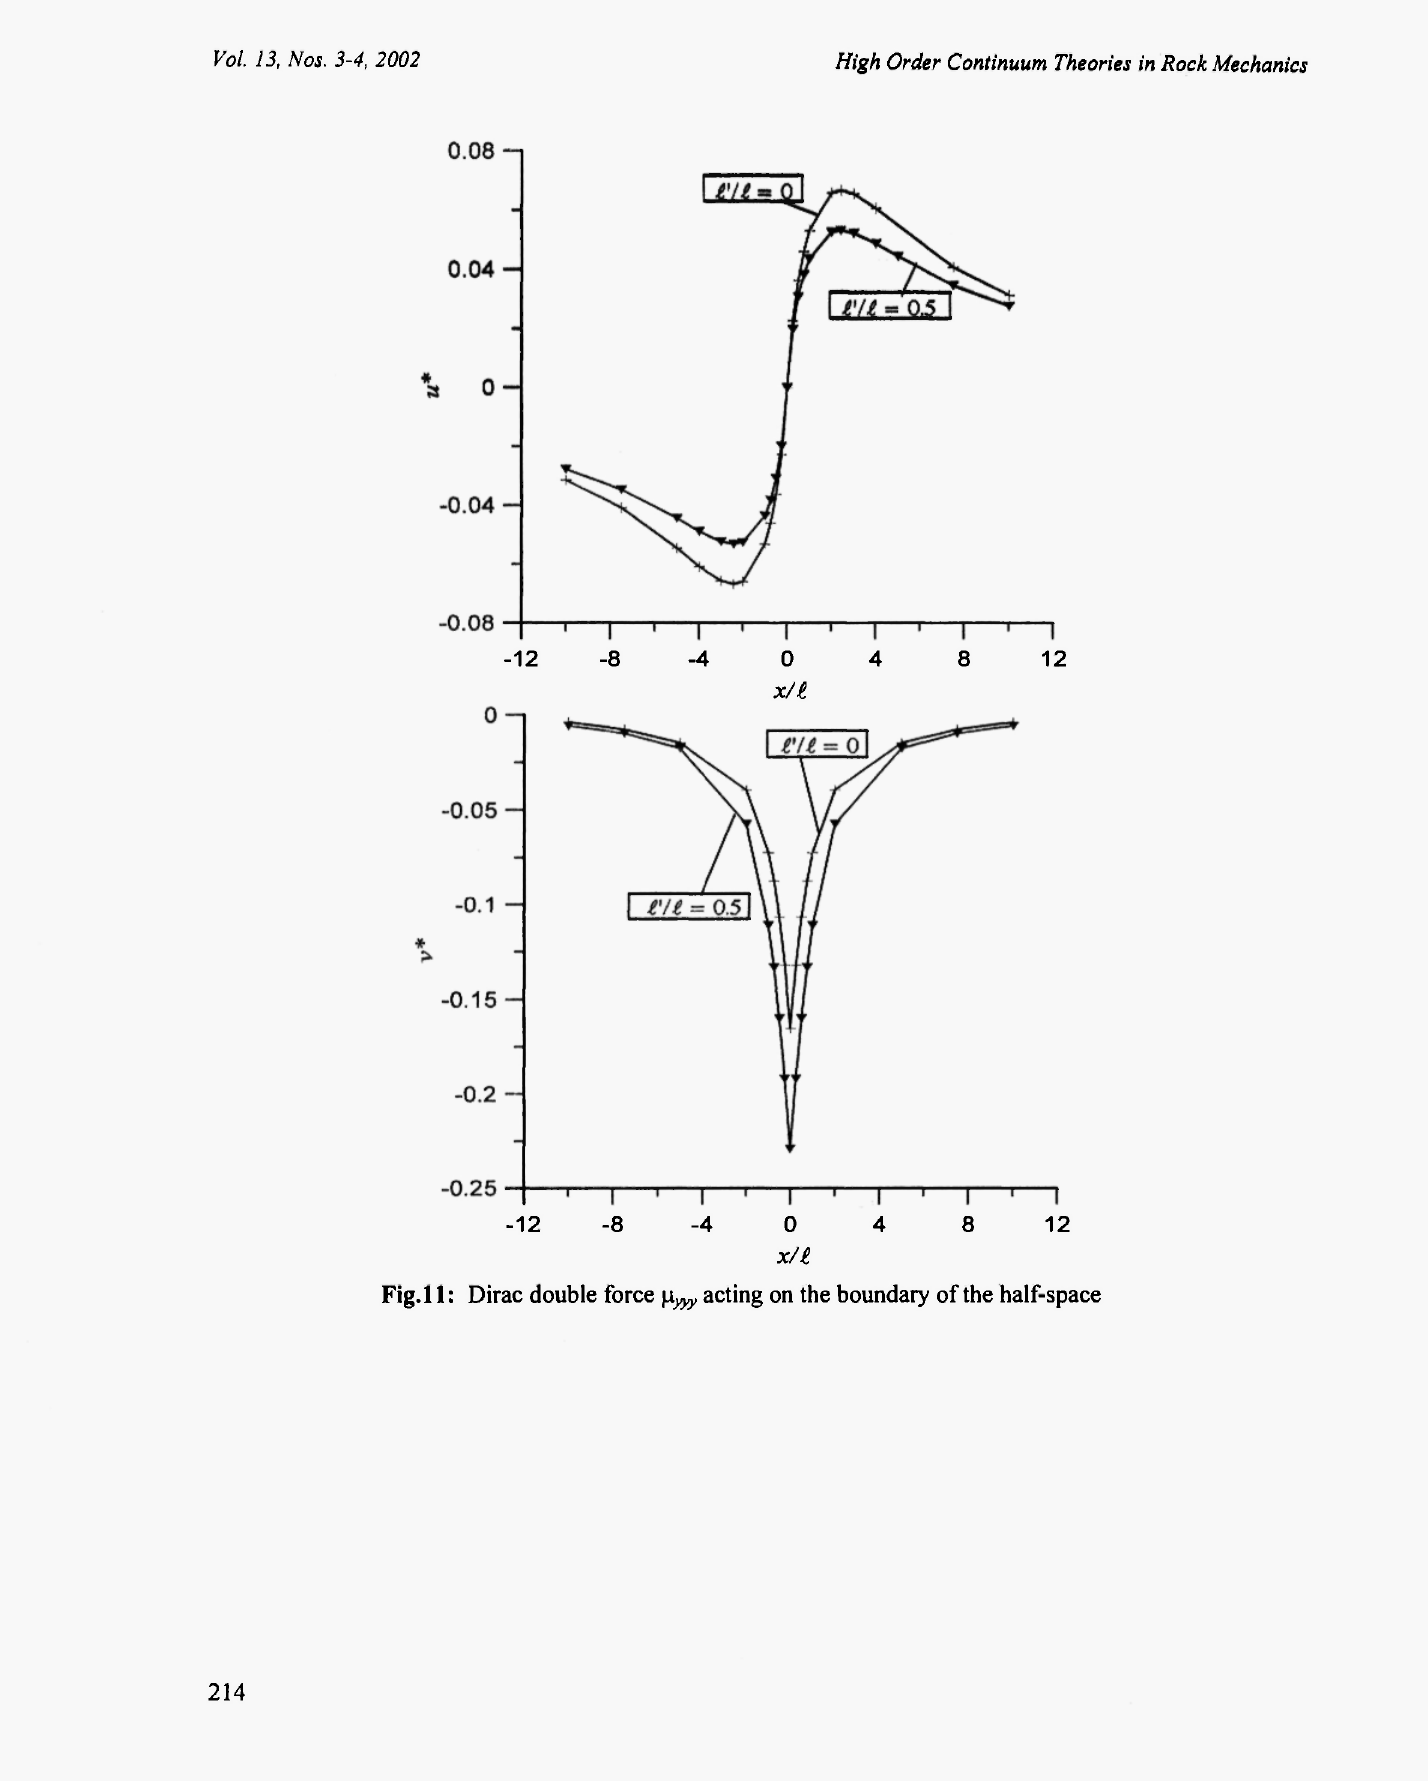
Fig.l 1: Dirac double force μ m acting on the boundary of the